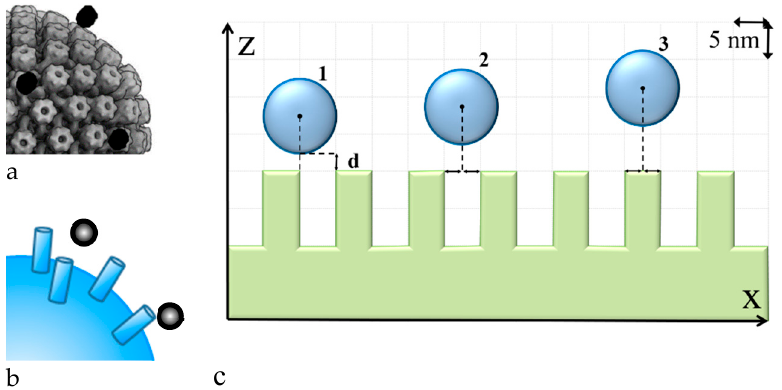
Figure 3. Sketch of the studied system. ( a ) is an idealized view of the virus surface with adsorbed nanoparticles; ( b ) is a model for calculations of adsorption potential for different sites of nanoparticles relative to virus spikes; ( c ) is the cross-section of ’b´.